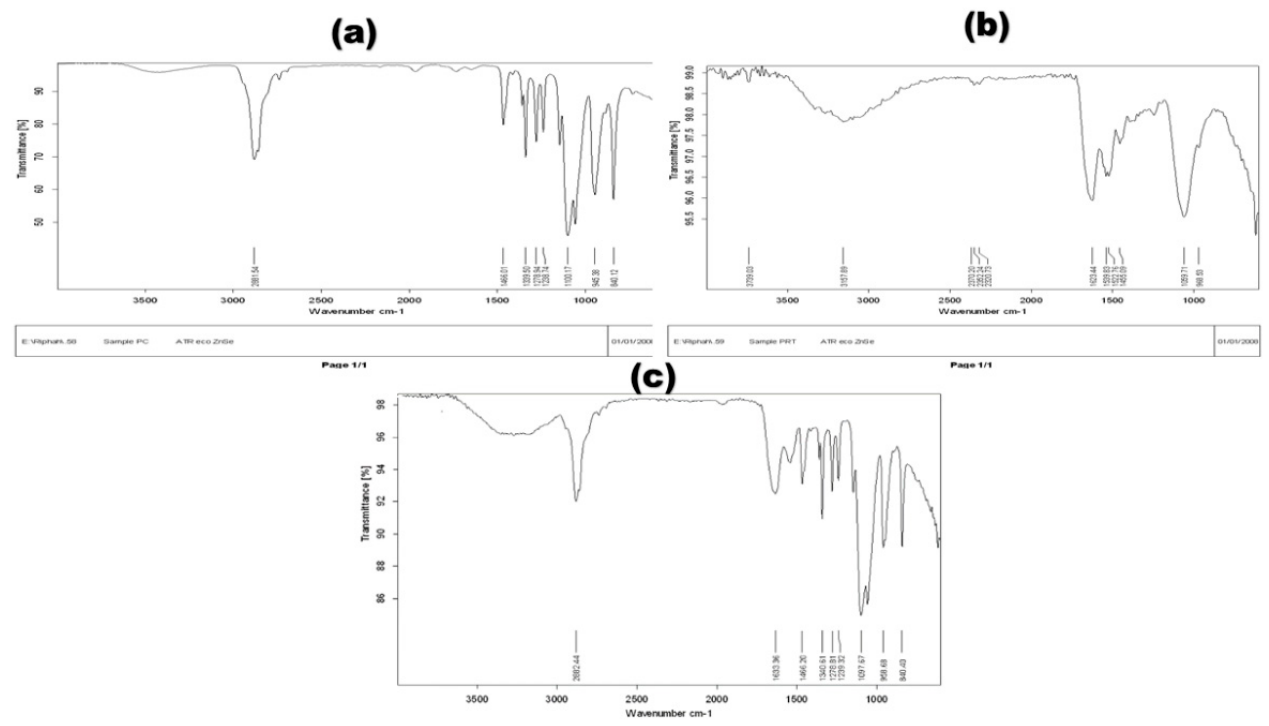
Figure 1. ( a ) FTIR of PEG-carboxylate, ( b ) protamine sulphate, and ( c ) PEG-protamine